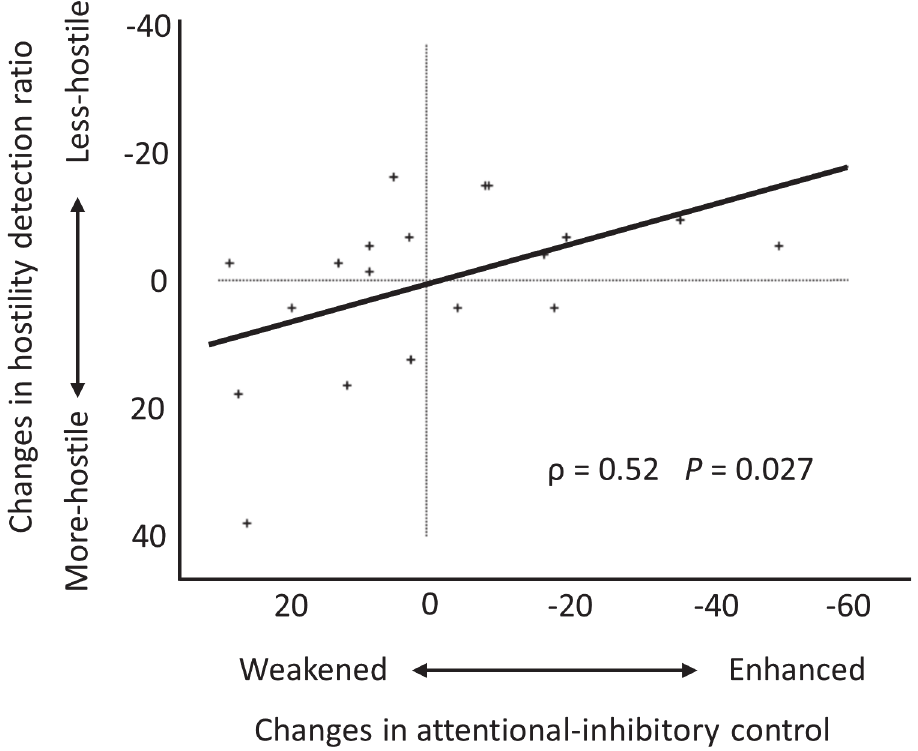
Fig 5. Scatter plot of the OT-induced changes on the facial emotion recognition task and on the flanker task. The vertical axis represents the OT-induced changes (i.e., OT [post — pre] — placebo [post — pre]) in the interpretation of facial expression for the combined uncertain (i.e., neutral and ambiguous) conditions. The horizontal axis represents the OT-induced changes (i.e., OT [post — pre] — placebo [post — pre]) in conflict duration on the flanker task. Notably, the change to less-hostile facial cognition was associated with enhanced attentional-inhibitory control after OT administration. The solid line denotes the regression line.